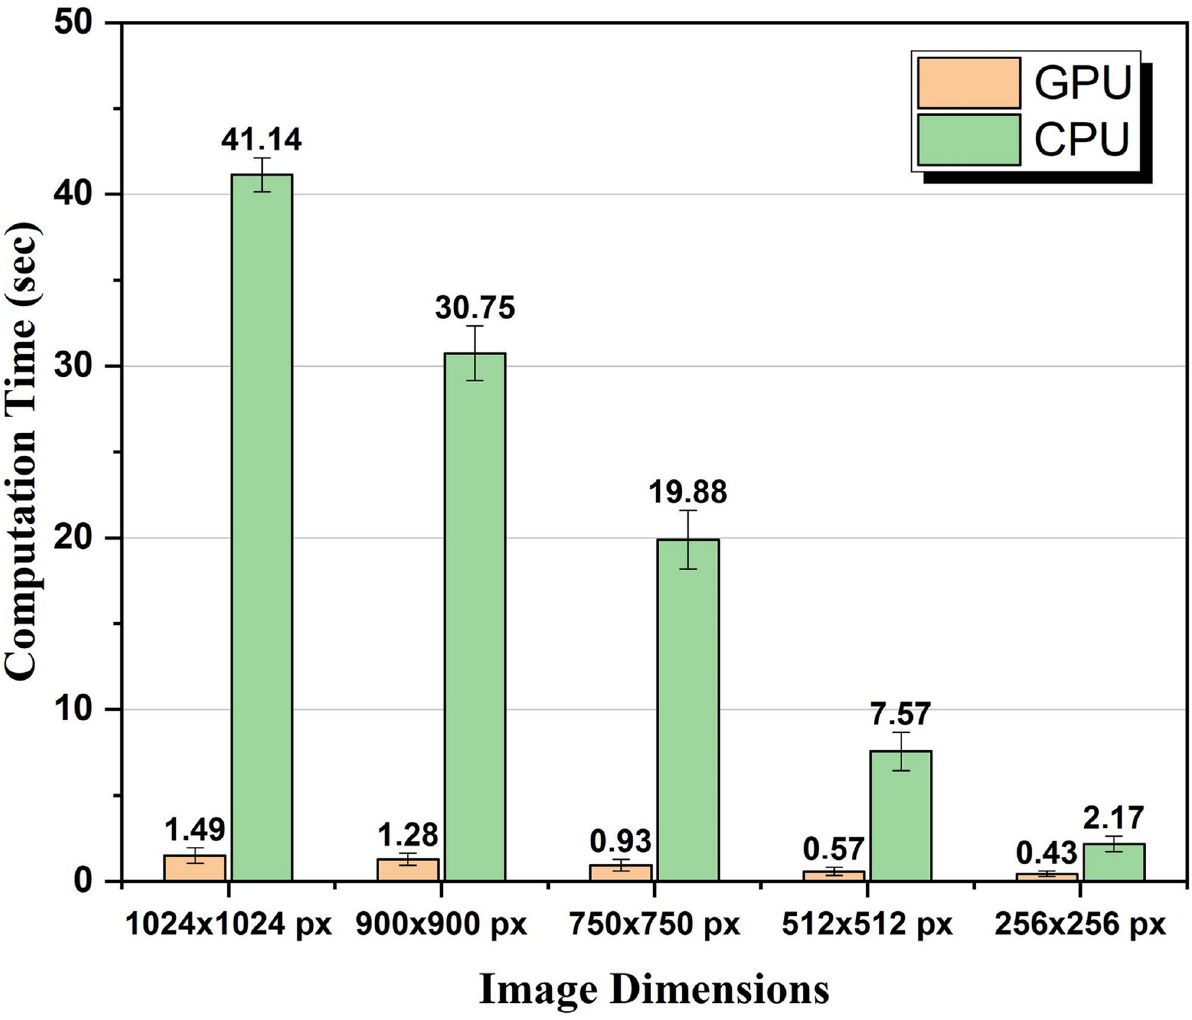
Fig 12. Total GPU and CPU computation times of SIM reconstruction algorithms executed using images with different